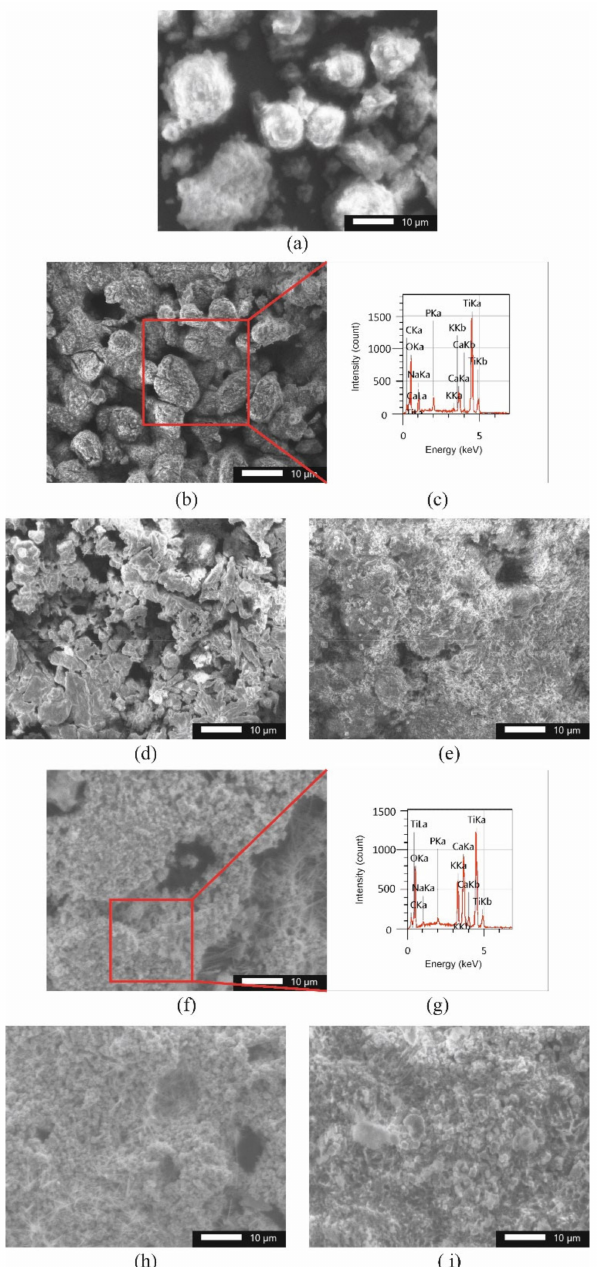
Figure 5. Scanning electron microscopy (SEM): ( a ) shellac-coated hydroxyapatite before sintering; Ti-HA composites ( b ) S1, ( d ) S2, ( e ) S3, ( f ) S4, ( h ) S5, and ( i ) S6. Energy dispersive X-ray (EDX) analysis: ( c ) S1 and ( g )